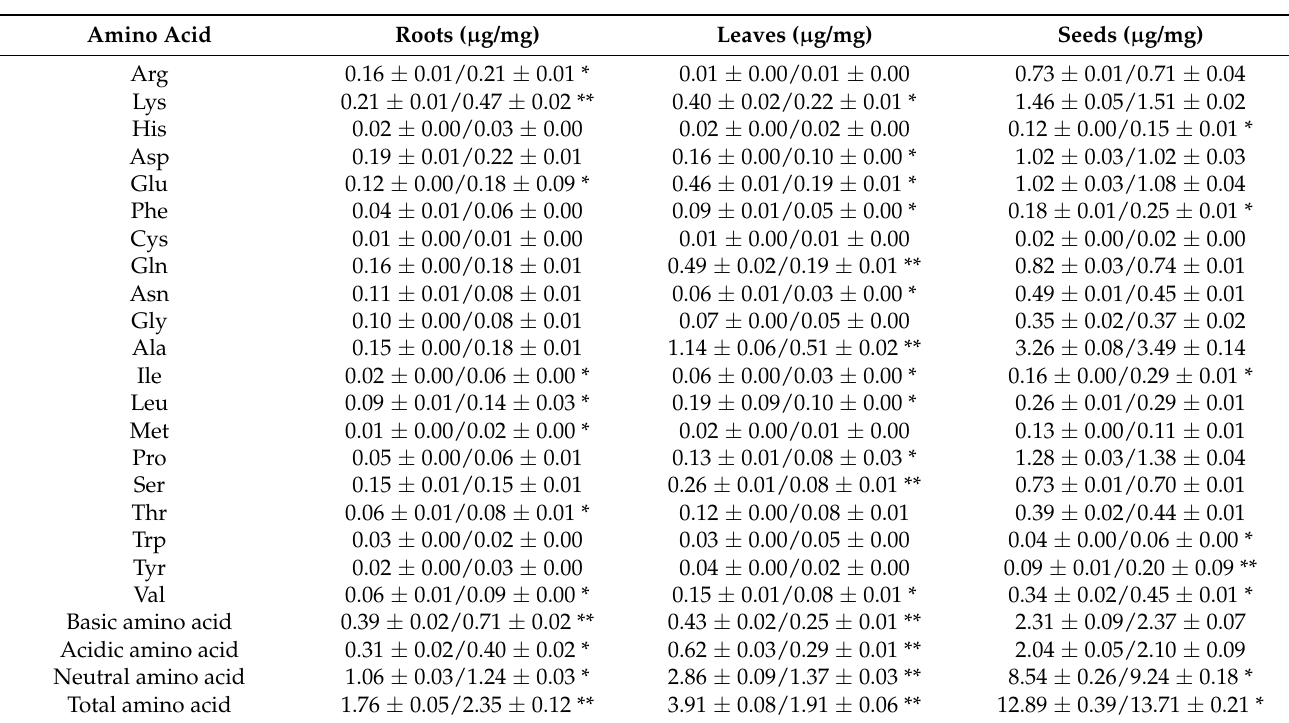
Table 3. Contents of 20 amino acids in different tissues of transgenic AtAAP1 maize plants with the endosperm-specific promoter. Data are presented in negative/positive plants. Symbols “*” and “**” indicate significant differences at p values of 0.05 and 0.01,